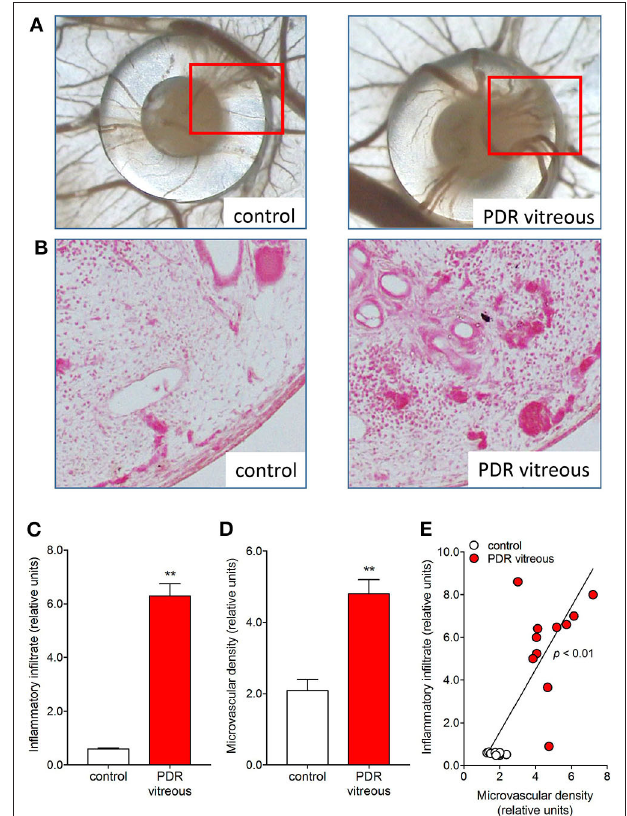
FIGURE 3 | PDR vitreous induces an angiogenic/inflammatory response in the chick embryo CAM. (A) Macroscopic pictures of the CAM at day 12 of incubation, showing a silicon ring containing vehicle (control) and a PDR vitreous sample. Note a strong angiogenic response in the experimental sample as compared to the control one. (B) Histological sections of the marked areas evidenced in (A) . Note a strong angiogenic response and a dense inflammatory reaction in the experimental sample as compared to the control one. (C, D) Morphometric quantification of the inflammatory infiltrate area (C) and of the microvascular density area (D) . (E) Correlation between microvascular density and inflammatory infiltrate induced by PDR vitreous in the CAM assay. ** p < 0.01 v s control, Student’s t